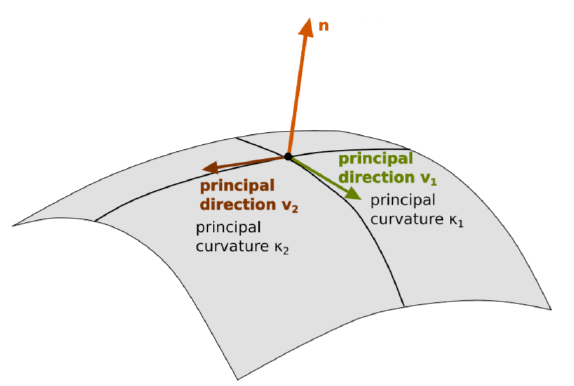
Figure 4. The curvatures along the principal directions.